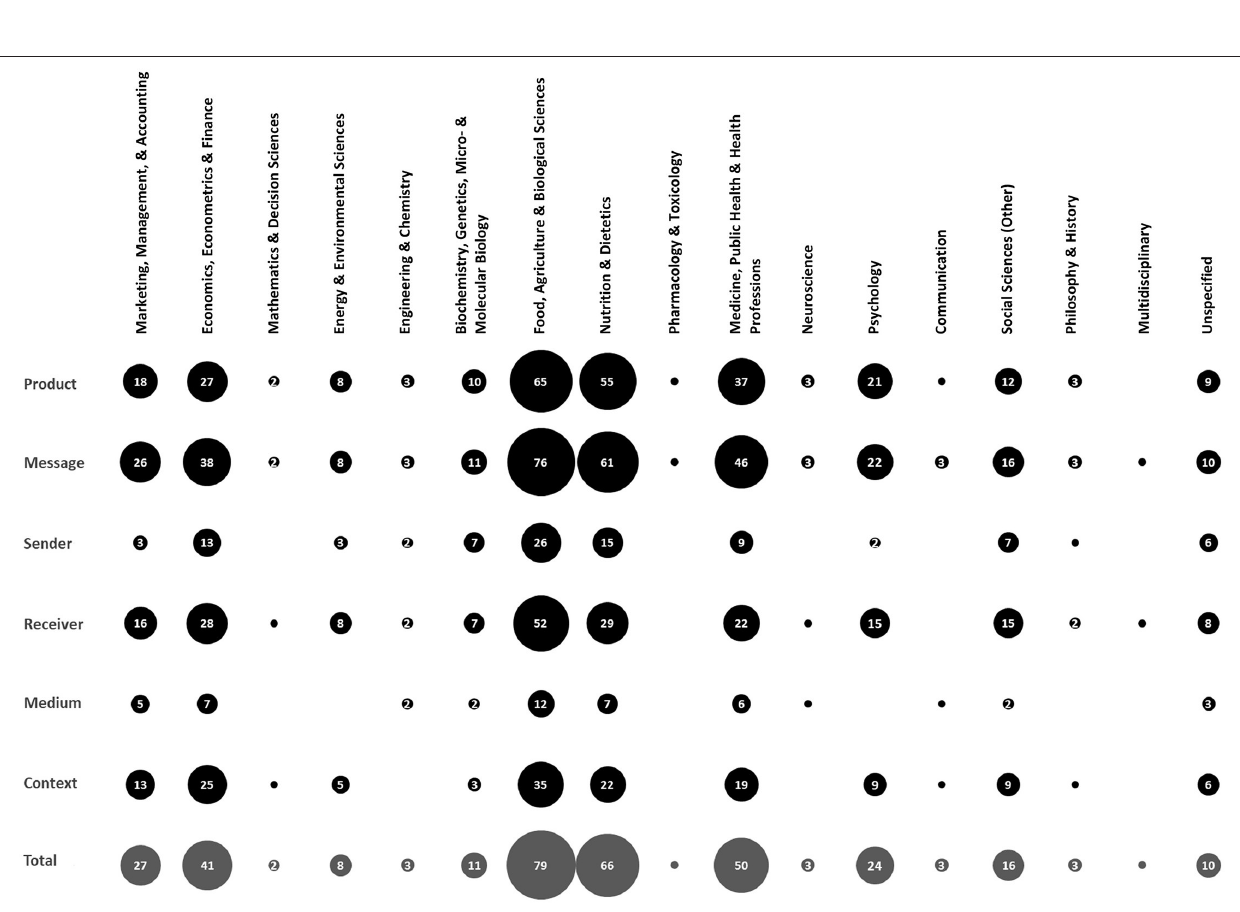
Frontiers in Nutrition |